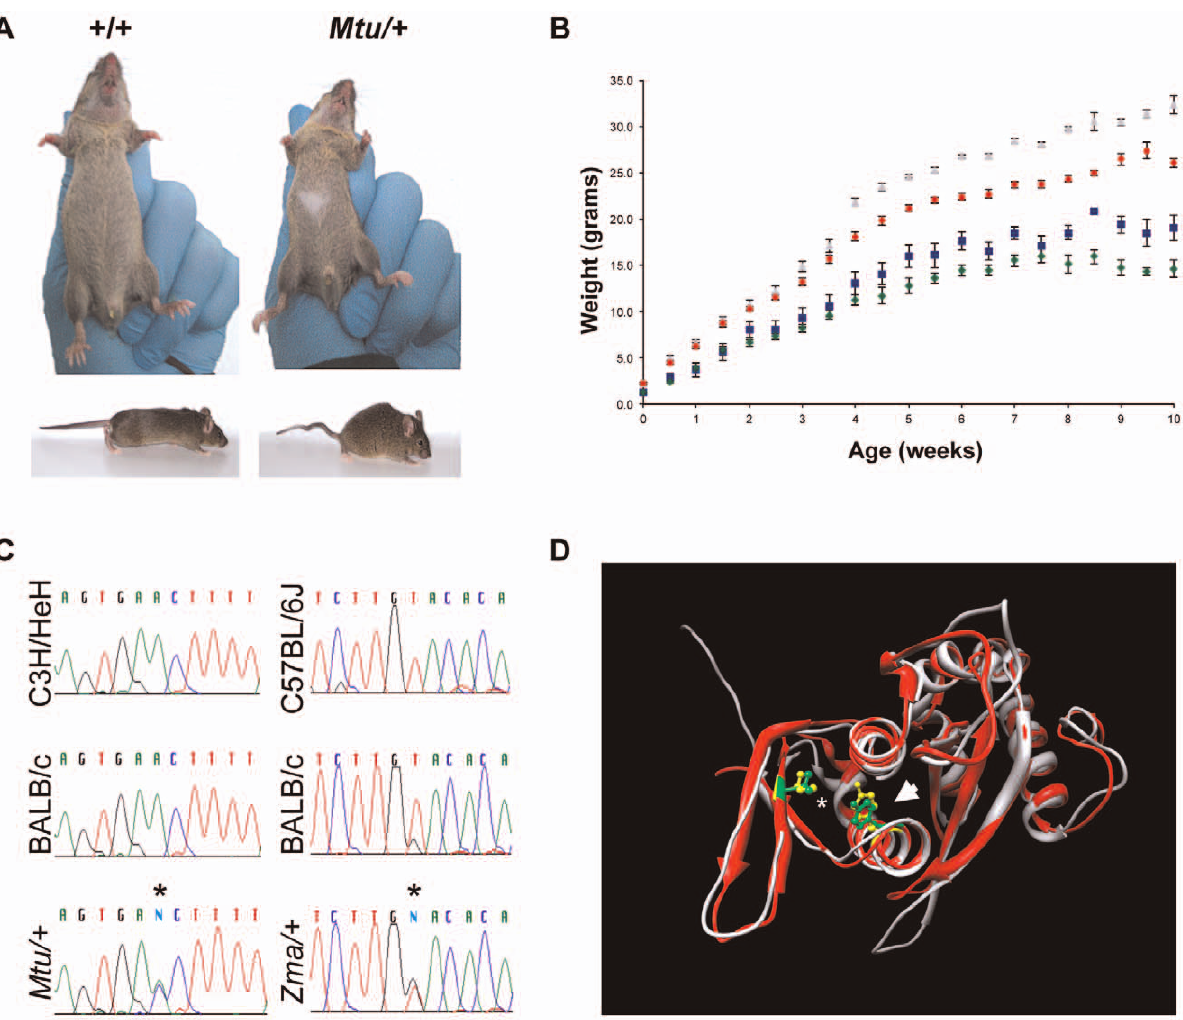
Figure 1. Heterozygous mutation of Rps7 results in visible white spotting, small body size, and tail kinking. (A) Montu ( Mtu ) heterozygous mice exhibiting a white belly spot and kinked tail were identified in an ENU mutagenesis screen. An independent ENU screen identified zuma ( Zma ) mice with similar phenotypes (data not shown). (B) Heterozygote Mtu/ + male (blue) and female (green) mice have a significantly reduced body weight compared to wild-type male (gray) and female (red) littermates. (C) Sequencing revealed novel Rps7 point mutations in Mtu/ + (c.574T . G, encoding p.V156G) and Zma/ + (c.637A . C, encoding p.Y177S) mice. Sequence traces shown are for the antisense strand. Detailed Rps7 genomic structure information can be found at http://www.ncbi.nlm.nih.gov/gene/20115. (D) The predicted structural locations of mutated amino acids in Rps7 Mtu and Rps7 Zma alleles. The three-dimensional structures of RPS7 orthologs from S. cerevisiae (PDB ID 3U5C_H, red) and T. thermophila (PDB ID 2XZM_3, gray) are superimposed. The locations of the residues homologous to mouse p.V156 (*) and p.Y177 (arrow) are shown in green ( S. cerevisiae ) and in yellow ( T. thermophila ). Image generated with UCSF Chimera.